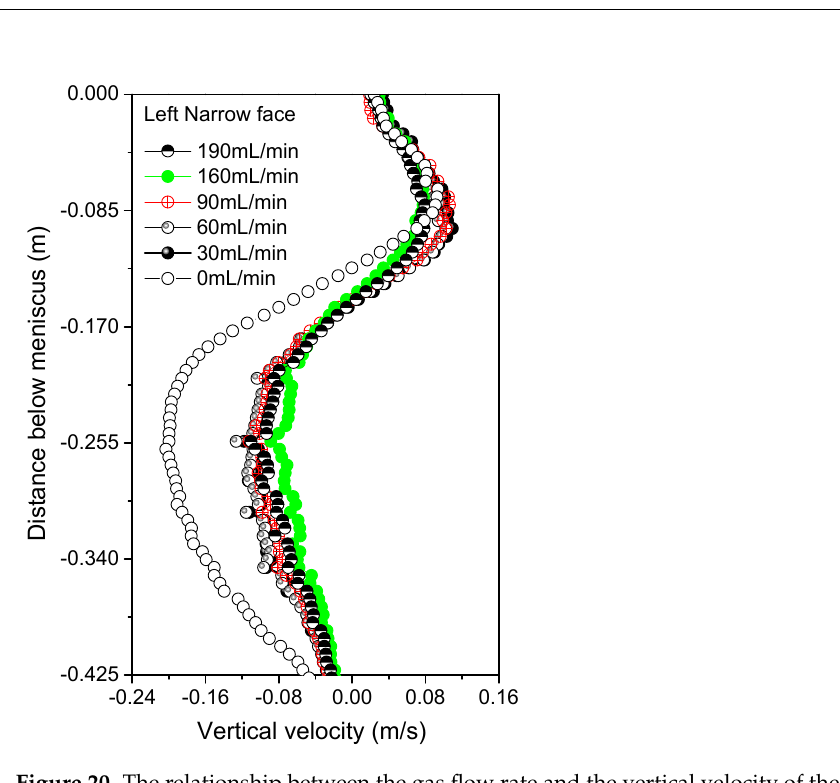
Figure 20. The relationship between the gas flow rate and the vertical velocity of the narrow surface.